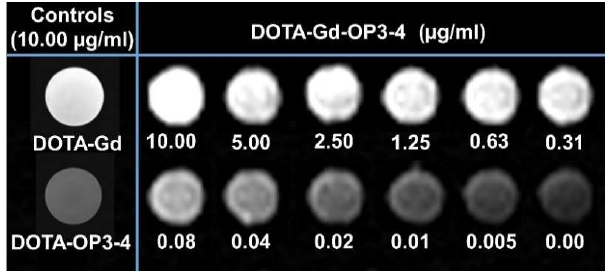
Figure 5. T1 weighted MRI scan of DOTA-Gd-OP3-4 showing a concentration-dependent signal intensity. The peptides, pre-dissolved in DMSO, were diluted to the desired concentration in PBS buffer (1 mL) and the MRI signal acquired at the same time using the parameters: SL5, TE 8.7, and TR550. DOTA-Gd (MW 557.64 g/mol) and DOTA-Gd-OP3-4 (MW 2141.4 g/mol) were prepared at a concentration of 1 μg/ml, corresponding to 1.79 μM and 0.47 μM Gd, respectively.